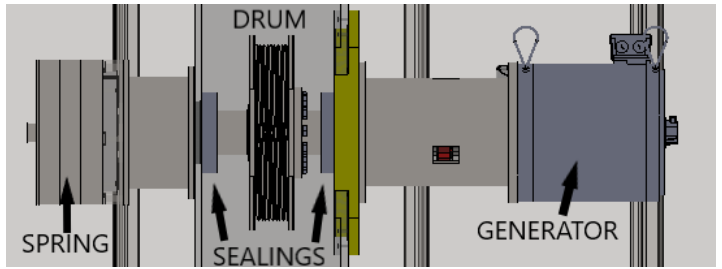
Figure 2. WEPA PTO